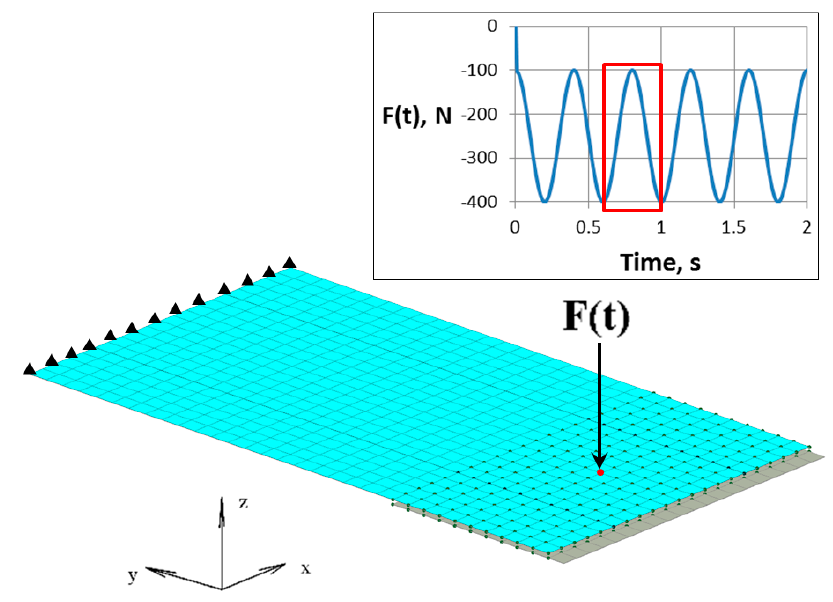
Figure 2. Model for verification.